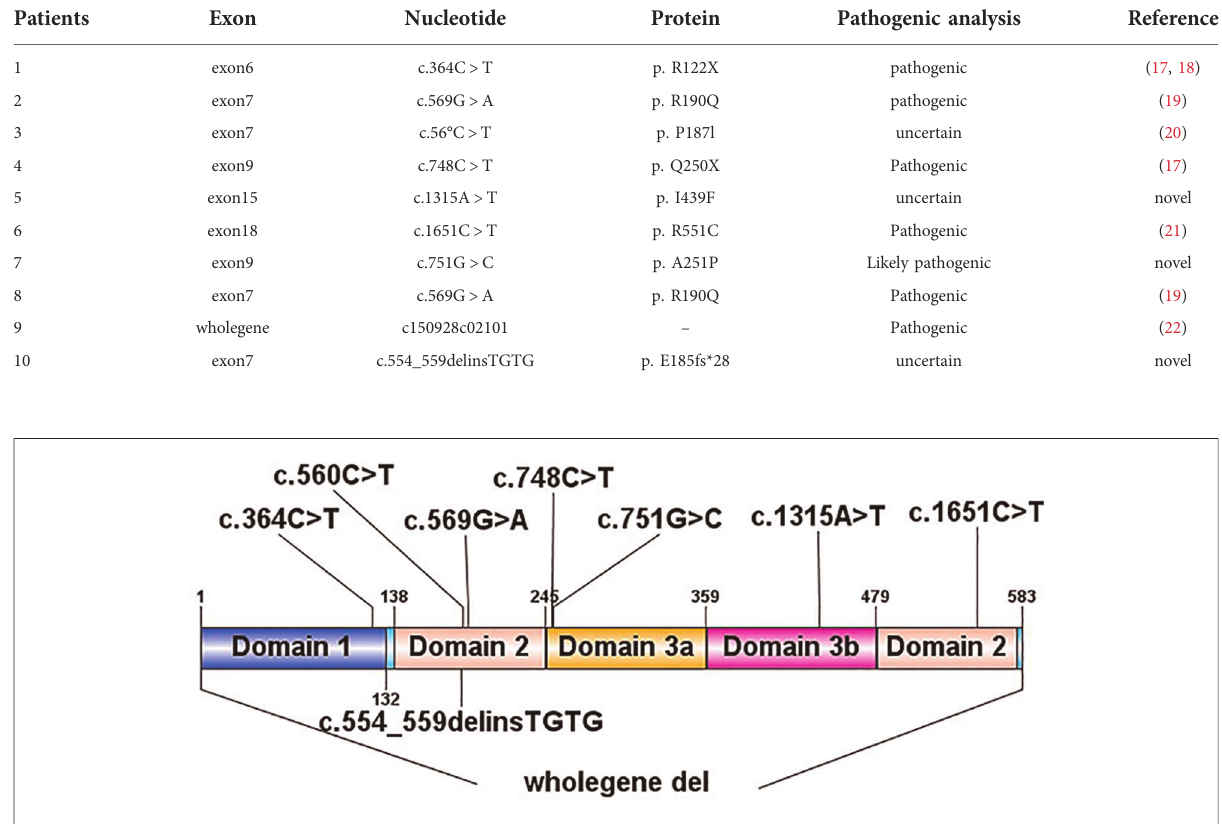
FIGURE 1 Pathogenic STXBP1